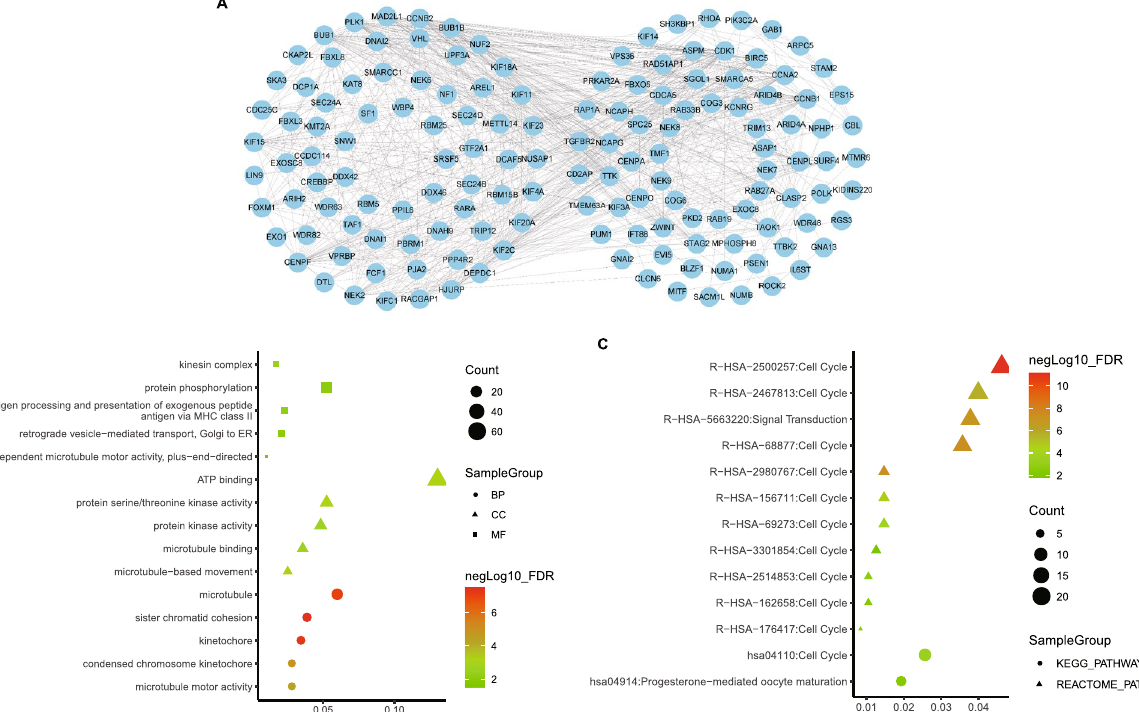
Figure 8. Predicted functions and pathways of the mutations in NEKs and their 50 frequently altered neighbor genes in NSCLC patients. Network of NEKs mutations and their 50 frequently altered neighbor genes was constructed ( A ). GO functional enrichment analysis predicted three main functions of NEKs mutations and their 50 frequently altered neighbor genes, including biological process, cellular components and molecular functions ( B ). KEGG pathway analysis on NEKs and their 50 most frequently altered neighbor genes was shown at figure ( C